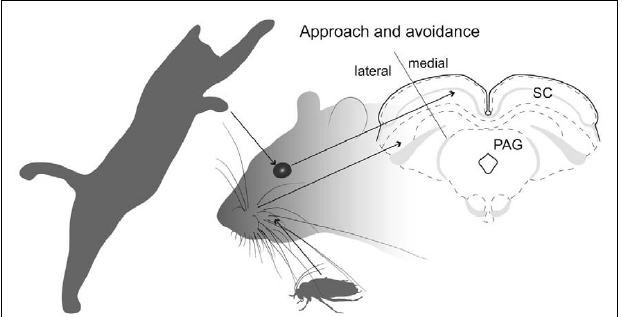
FIGURE 1 | SC’s spacial maps. Illustration shows that predator movements in the upper visual field are detected in the medial sub-region of the rodent SC’s retinotopically organized map, which promotes defense-like responses.Whisker-related somatosensory stimuli associated with prey are detected in the lateral sub-region of the SC which evokes approach and appetitive behavior.